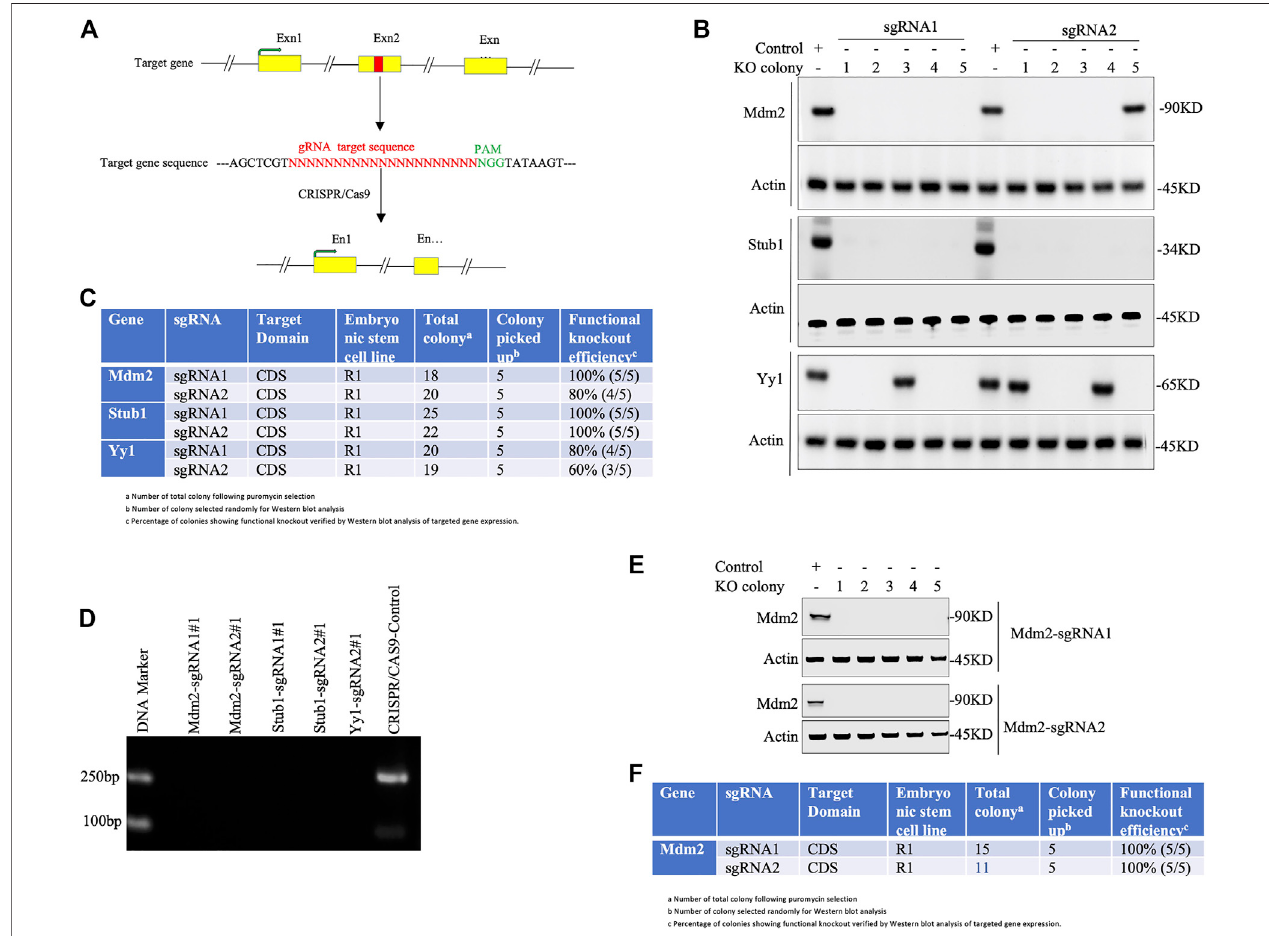
FIGURE3| Knockoutvalidationinpluripotentstemcells. (A) Simpli fi edrepresentationofasgRNAtargetingexon(designatedasExn1,Exn2,Exn3, ... )ofagenomicDNA.